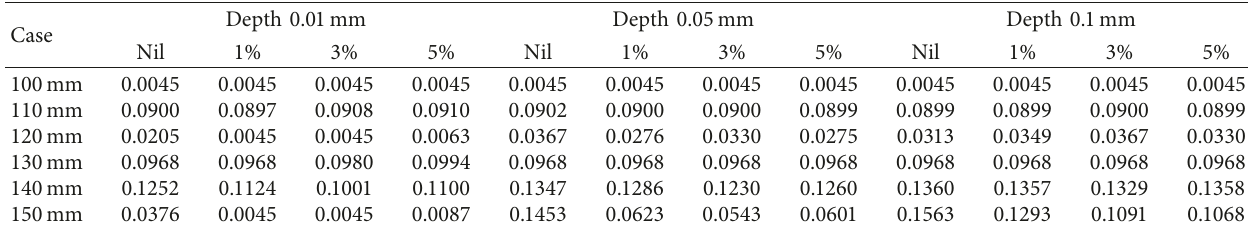
Figure 12: The estimation results of rail corrugation wavelength. (a) At different depths of rail corrugation. (b) At different train speeds. Table 3: Wavelength estimation error at different depths of rail